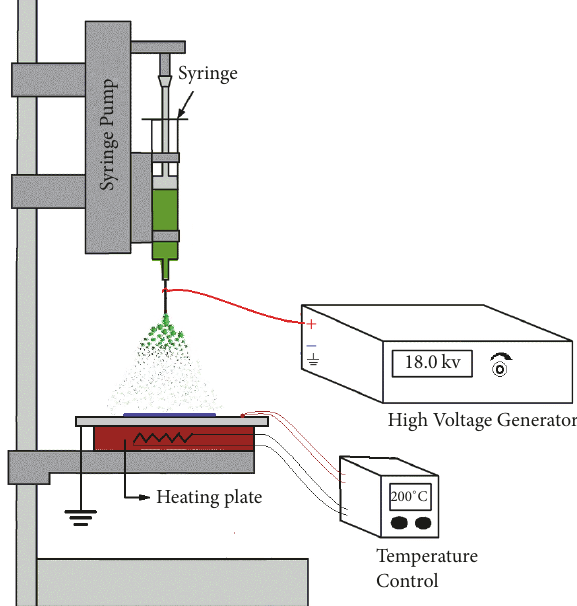
Figure 1: Experimental setup for deposition of ZnO thin films by the method of